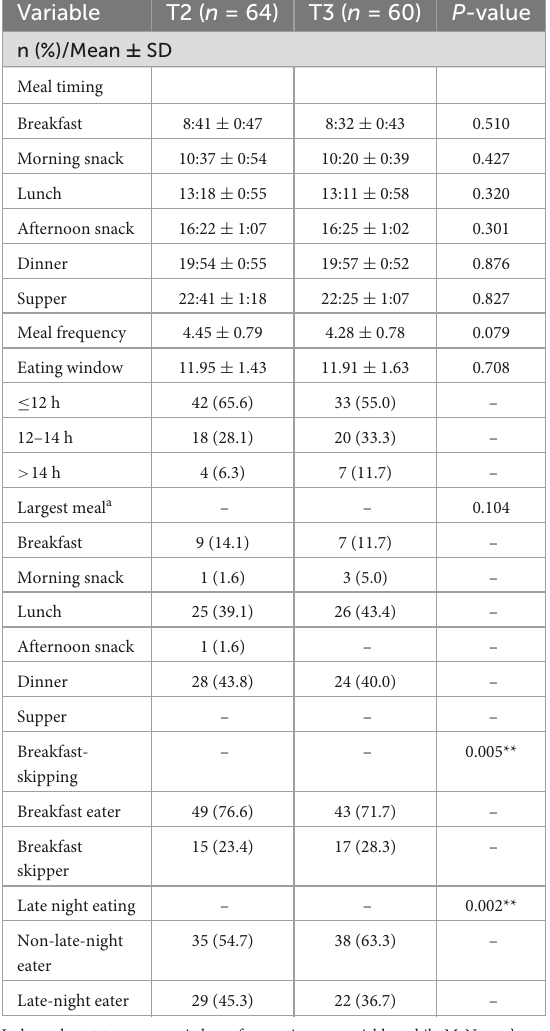
TABLE 2 Chrononutrition characteristics of the pregnant women during second ( n = 64) and third trimester ( n =